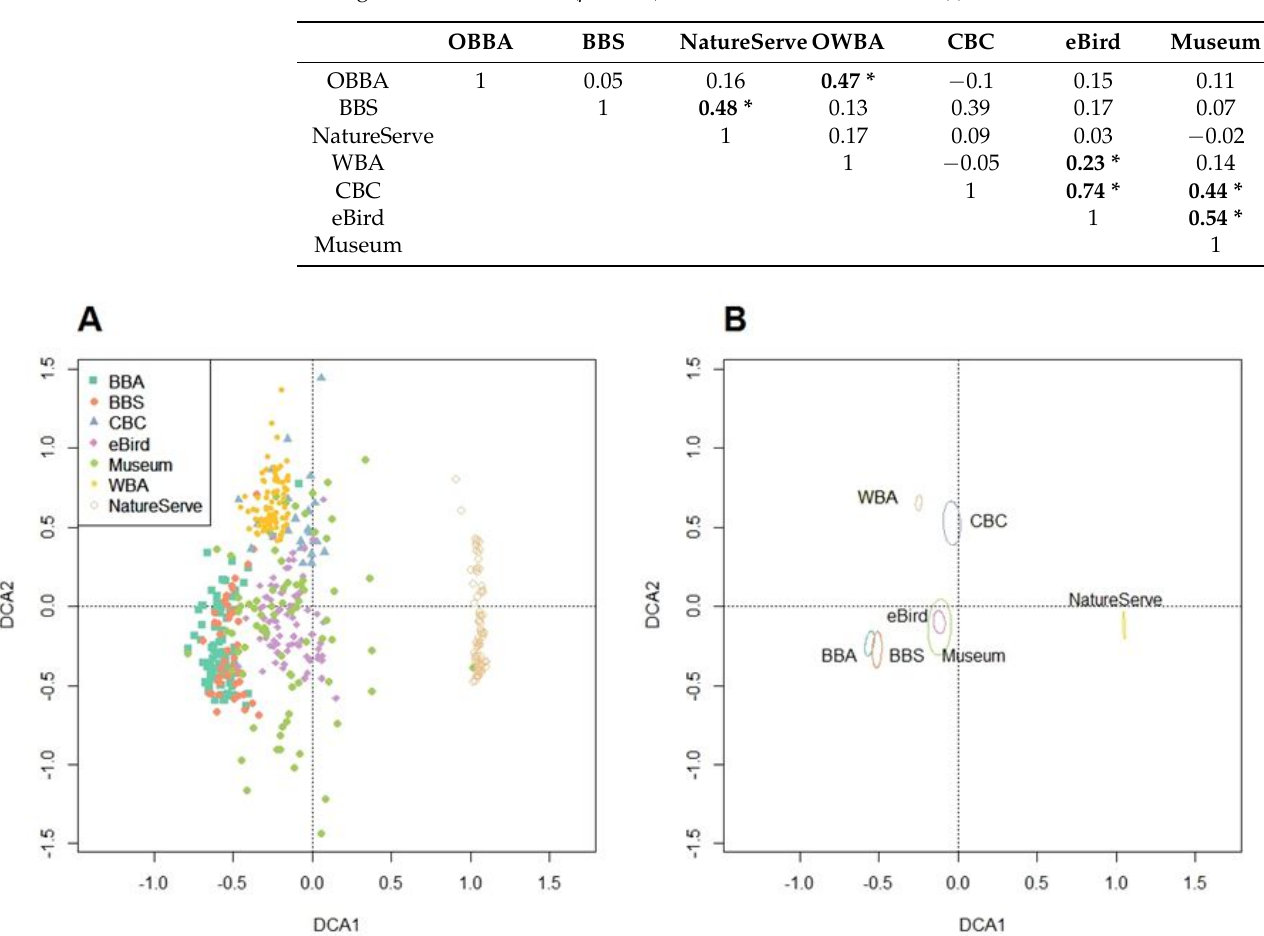
Table 4. Total number of species of conservation concern recorded by each method for the 77 counties in Oklahoma. County